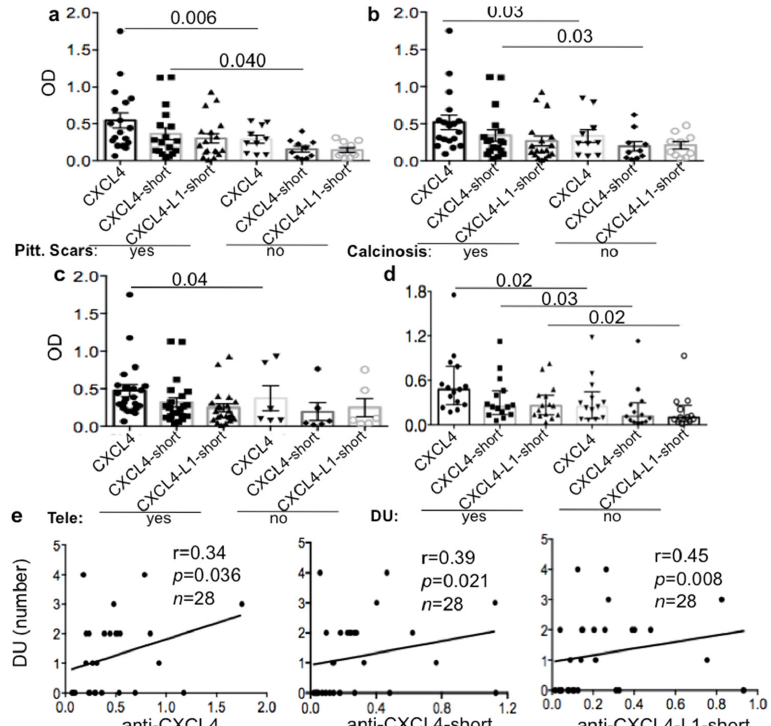
Figure 2. Anti ‐ CXCL4 and/or CXCL4 ‐ L1 antibodies are higher in lsSSc patients with skin involvement. LsSSc patients with pitting scars ( a ), calcinosis ( b ), telangectasia ( c ) and digital ulcers (DU) ( d ) were tested for antibody reactivity to entire CXCL4 (CXCL4) or to the 27 mer peptides spanning the COOH ‐ term of CXCL4 (CXCL4 ‐ short) or CXCL4 ‐ L1 (CXCL4 ‐ L1 ‐ short), by ELISA. Results are reported as optical density (OD). Horizontal bars represent the mean, vertical bars are standard errors of the mean (SEM) in a–c and median plus interquartile range in ( d ), p values by Mann–Whitney test. ( e ) Number of DU in lsSSc plotted against anti ‐ CXCL4 (entire CXCL4) antibodies or antibodies directed to the COOH ‐ part of CXCL4 (anti ‐ CXCL4 ‐ short) or anti ‐ CXCL4 ‐ L1 (anti ‐ CXCL4 ‐ L1 ‐ short). Spearman “r” coefficient, p values and sample size n are indicated.